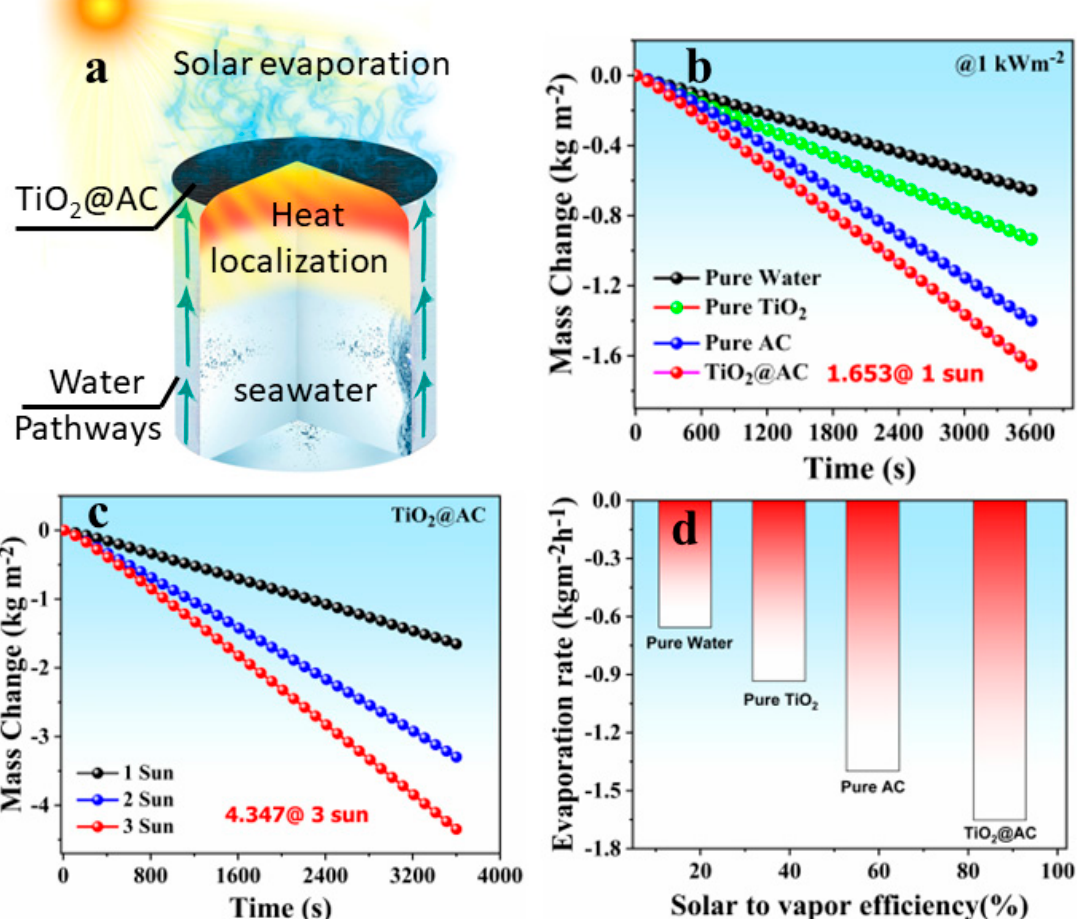
Figure 5. ( a ) Schematic illustration of the highly efficient TiO 2 /AC based solar evaporator showing excellent thermal sustainment on the top surface and of sideways water channels of cotton fabric facilitated smooth water transport of water while centralized PET suppressed heat losses and self- floating potential. ( b ) Comparative time-dependent mass change of pure water, TiO 2 , AC, and TiO 2 /AC solar evaporator under one sun irradiance. ( c ) Mass change of TiO 2 /AC solar evaporator for different solar intensities up to 3 kW m − 2 . ( d ) Comparative evaporation rates and solar-to-vapor conversion efficiencies of pure water, TiO 2 , AC, and TiO 2 /AC solar evaporator evaporating under one sun.